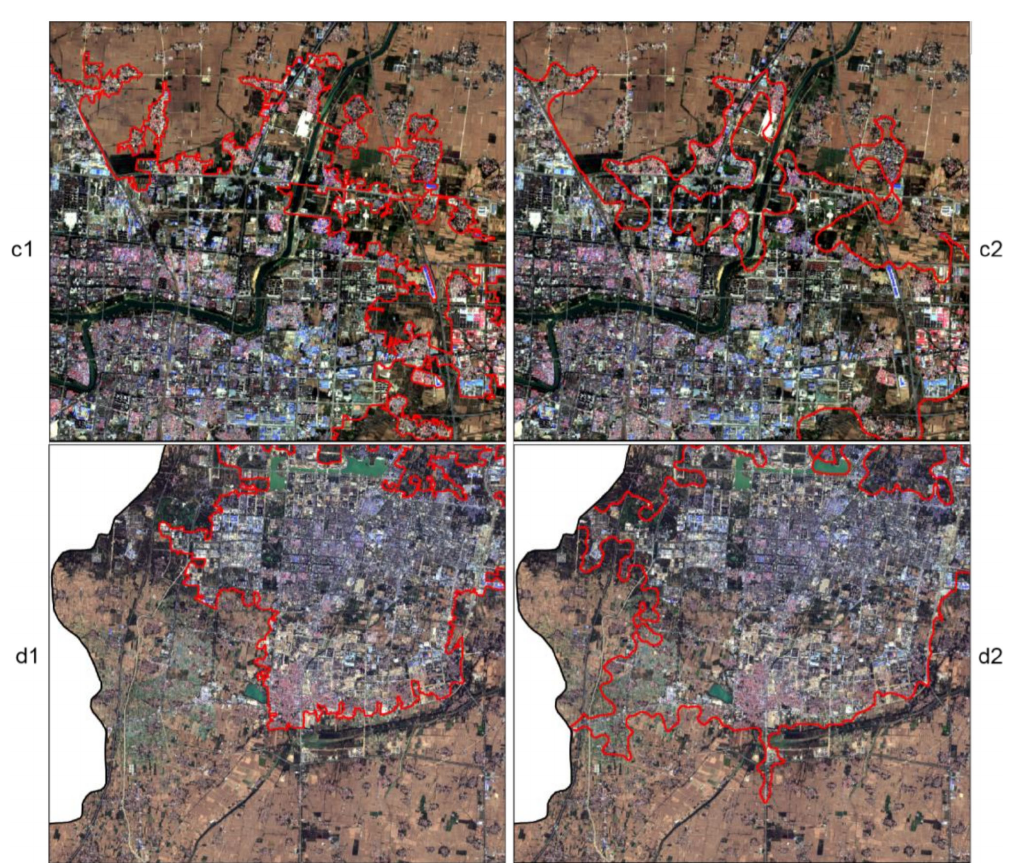
Figure 7. Comparison of urban boundaries between GUB (Henan) and HNUB2018. ( a1 – d1 ) and ( a2 – d2 ) are the areas with significant difference between GUB (Henan) and